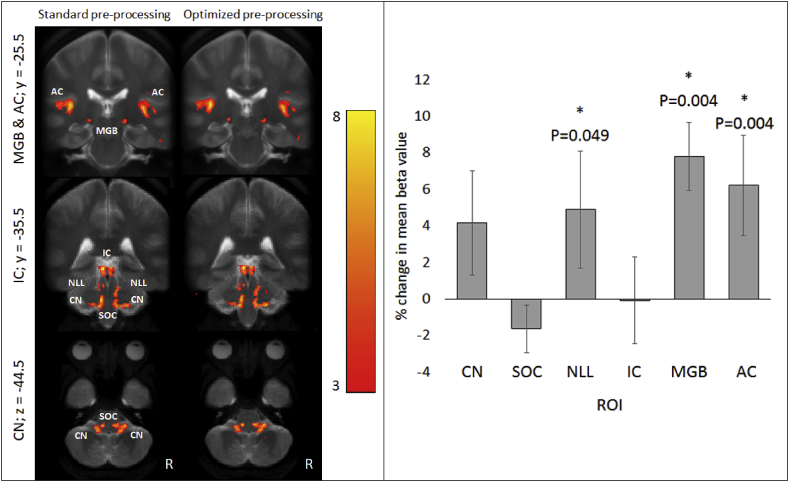
Interim analysis of the influence of distortion and physiological noise correction on sound related activity in the ascending auditory pathway. Left: Group-level (n = 25) sustained sound-related activation for “standard” versus “optimized” pre-processing (p < 0.001 uncorrected, k = 0 voxels) overlaid onto the group-level mean T2 turbo-spin echo image. ‘y’ and ‘z’ values denote the MNI slice co-ordinates of the coronal (top) and axial (bottom) images and the color bar denotes T statistic. Right: Group-level mean (±standard error) percent difference in beta values within spherical ROIs calculated for optimized (distortion correction and physiological noise correction) compared to standard pre-processing. A significant increase in beta value (* denotes p ​< ​0.05) is evident in the NLL, MGB and AC ROIs.